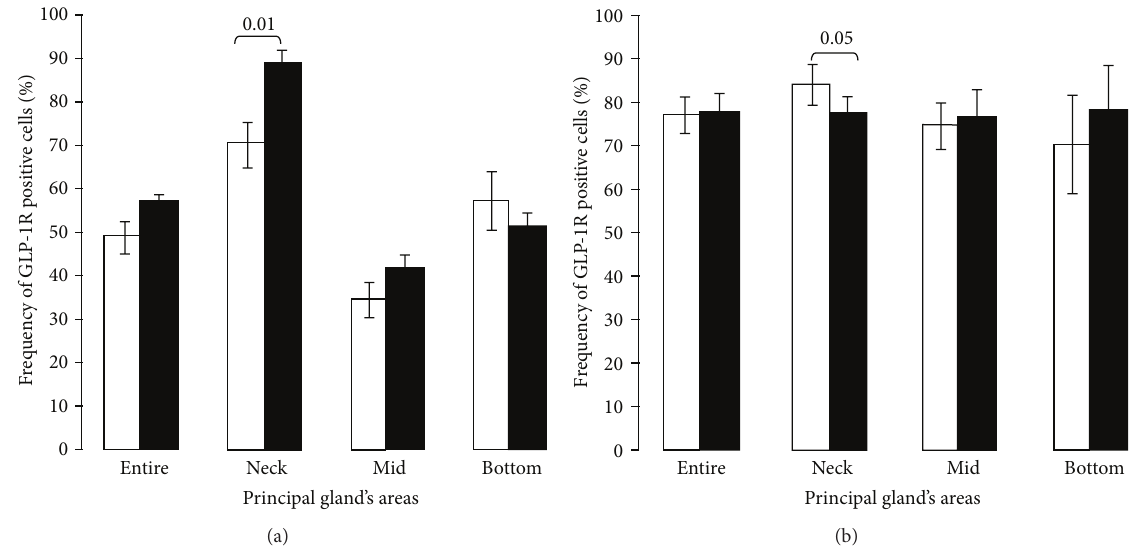
Figure 4: Different frequency of GLP-1R immunoreactive glandular cells in principal glands of diabetic PO and SPD rats. Frequency of GLP- 1R immunoreactive cells was determined by quantitative immunohistomorphological analysis in neck, mid, and bottom areas of principal glands. (a) A significant increase of GLP-1R bearing parietal cells in the neck area of principal glands in diabetic PO (black bars) as compared to control animals (white bars) ( 𝑃 = 0.01 ). (b) A significant decrease in GLP-1R bearing parietal cells in diabetic SPD compared with control animals ( 𝑃 = 0.05 ). Data are presented as mean ±